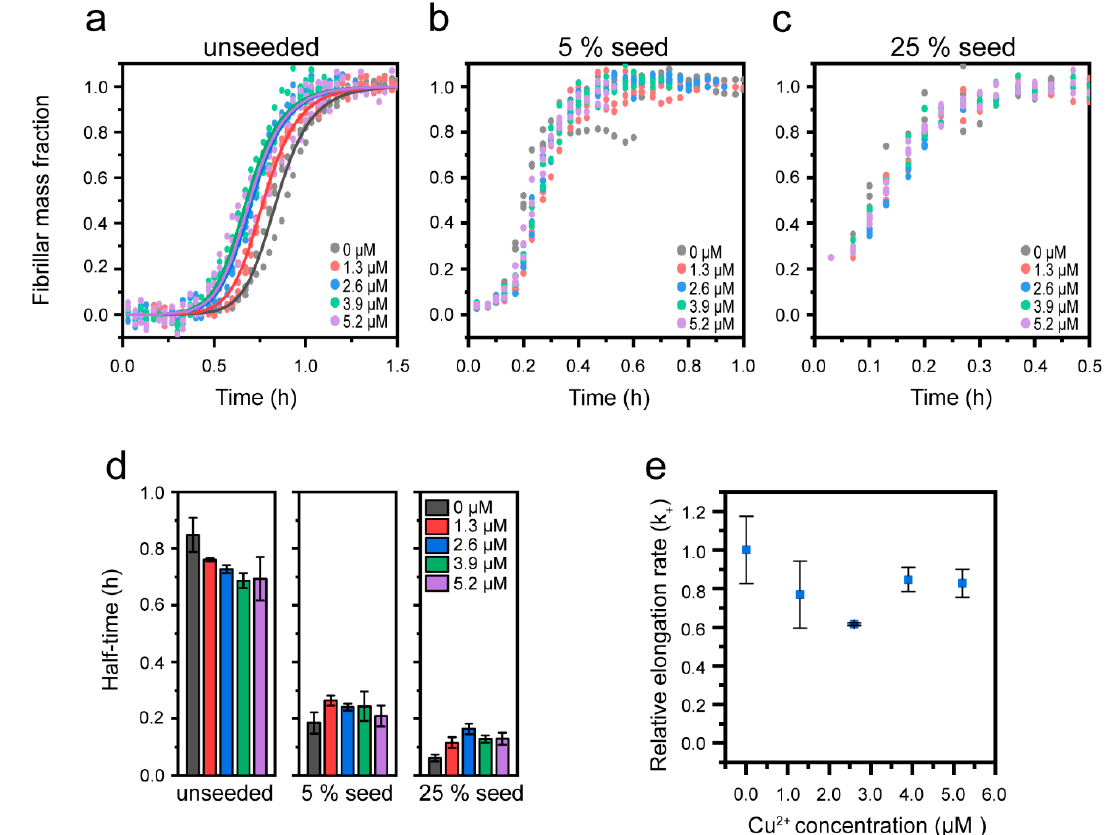
Figure 7. Effect of Cu + on seeded A β (1-42) amyloid formation at pH 8.0. ( a – c ) Normalized kinetic profiles of 2.6 µ M A β (1-42) in presence of indicated concentrations of Cu 2 + in reactions with ( a ) no seeds, ( b ) 5% seeds, and ( c ) 25% seeds. ( d ) Half-times of A β (1-42) aggregation extracted from the data in ( a – c ). Error bars represent the standard deviation (n = 3). ( e ) Relative elongation rate of 2.6 µ M A β (1-42) in the presence of 25% seeds as a function of Cu 2 + concentration, as estimated using a linear approximation of the kinetic slope up until a fibril mass fraction of 0.5. All the rate constants are relative to that of 2.6 µ M A β (1-42) in the absence of Cu 2 + . The solid lines in ( a ) are the global fits to data using a model for Cu 2 + -dependent variation in the combined rate constant for primary nucleation and elongation (k n k +